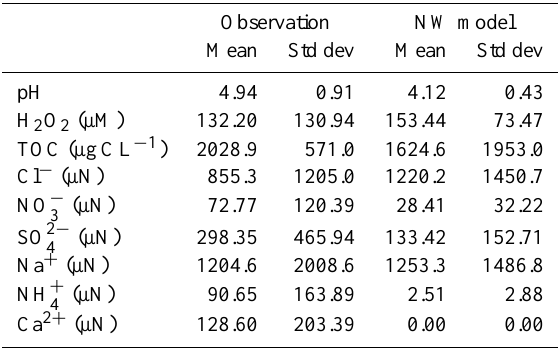
Table 3. Observed and modeled cloud chemistry statistics. Values where the observations (model) were inexistent were removed from the model (observations)